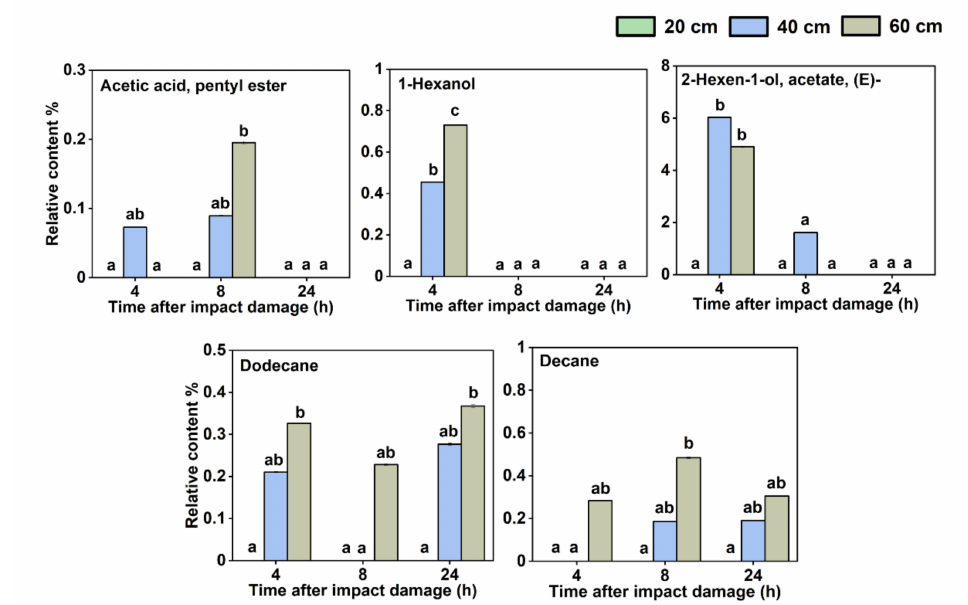
Figure 3. Five volatile organic compounds (VOCs) whose relative content was related to the extent of impact damage suffered by the fruit. Different letters (a, b, c, d) indicate significant differences ( p <